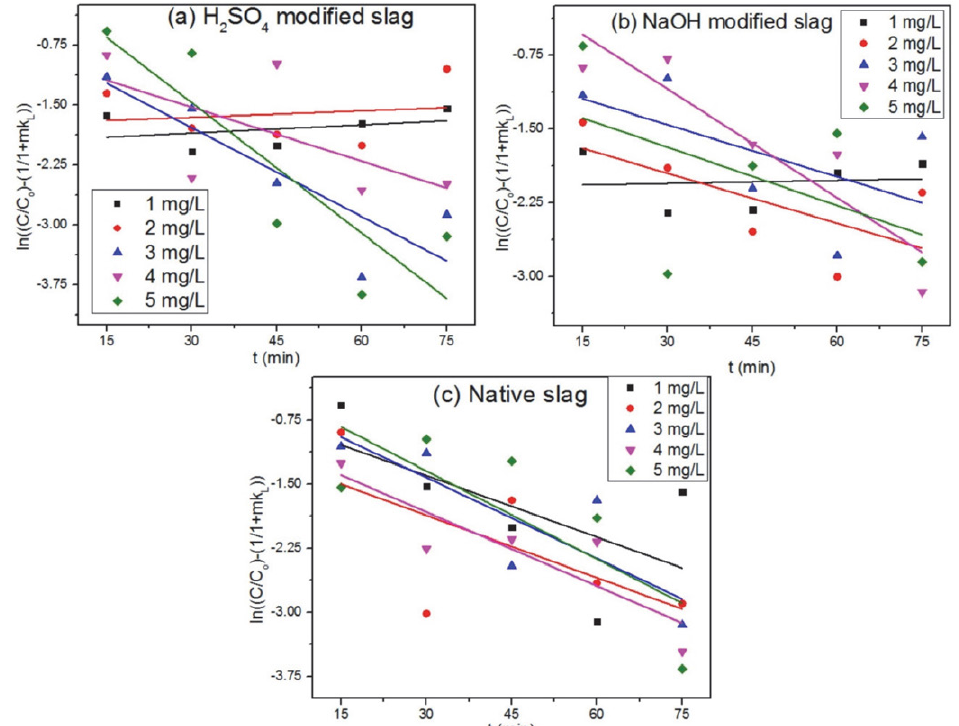
Figure 8. McKay et al mass transfer plots for native and modified slag at different initial As(III) concentrations